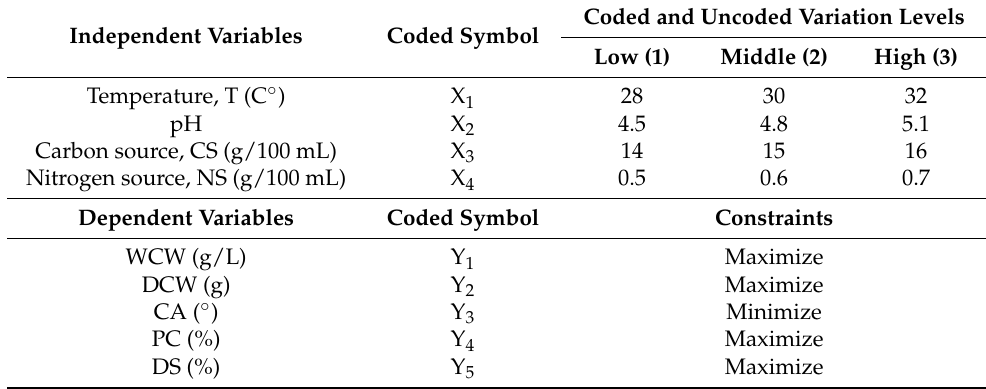
Table 1. Process variables and experimental conditions in the four-factor, three-level Taguchi design. Independent Variables Coded Symbol